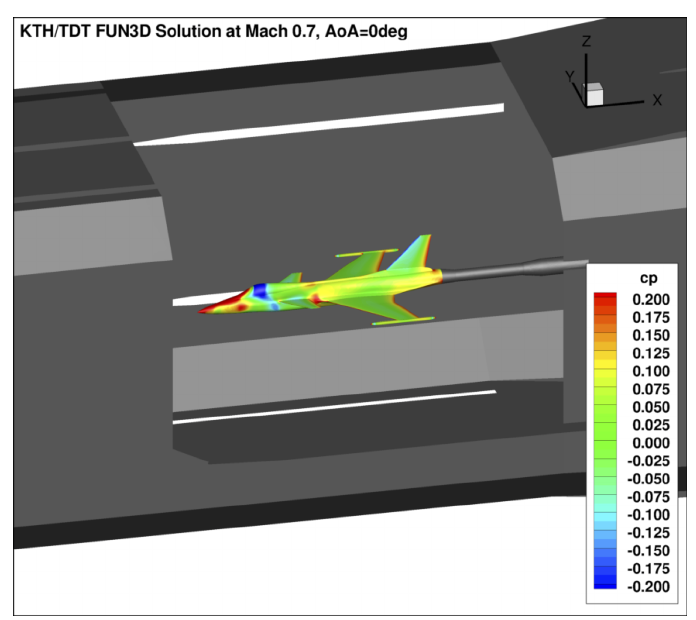
Figure 12. Pressure distributions at M = 0.7, AoA = 0 degrees on the KTH wind-tunnel model, as simulated inside the TDT using FUN3D code.